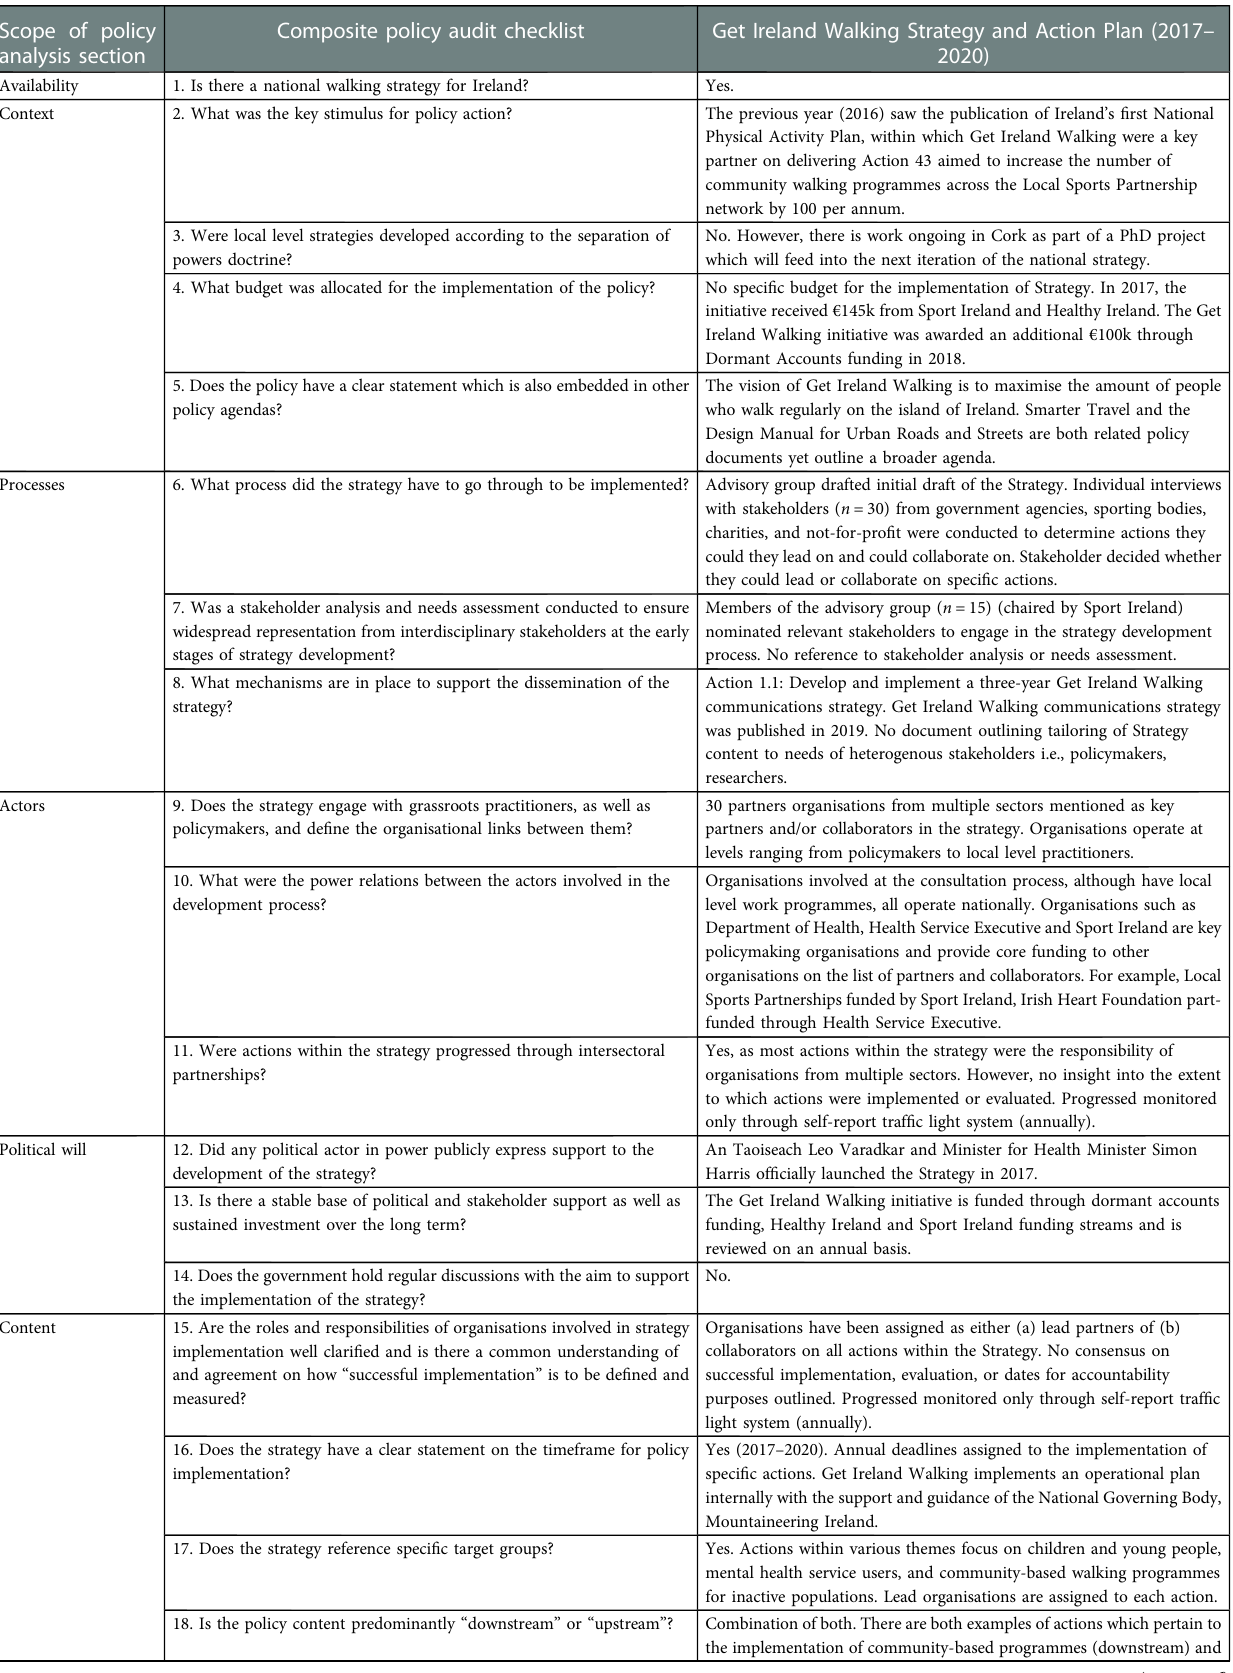
TABLE 1 Content analysis of the Get Ireland Walking Strategy and Action Plan 2017 –